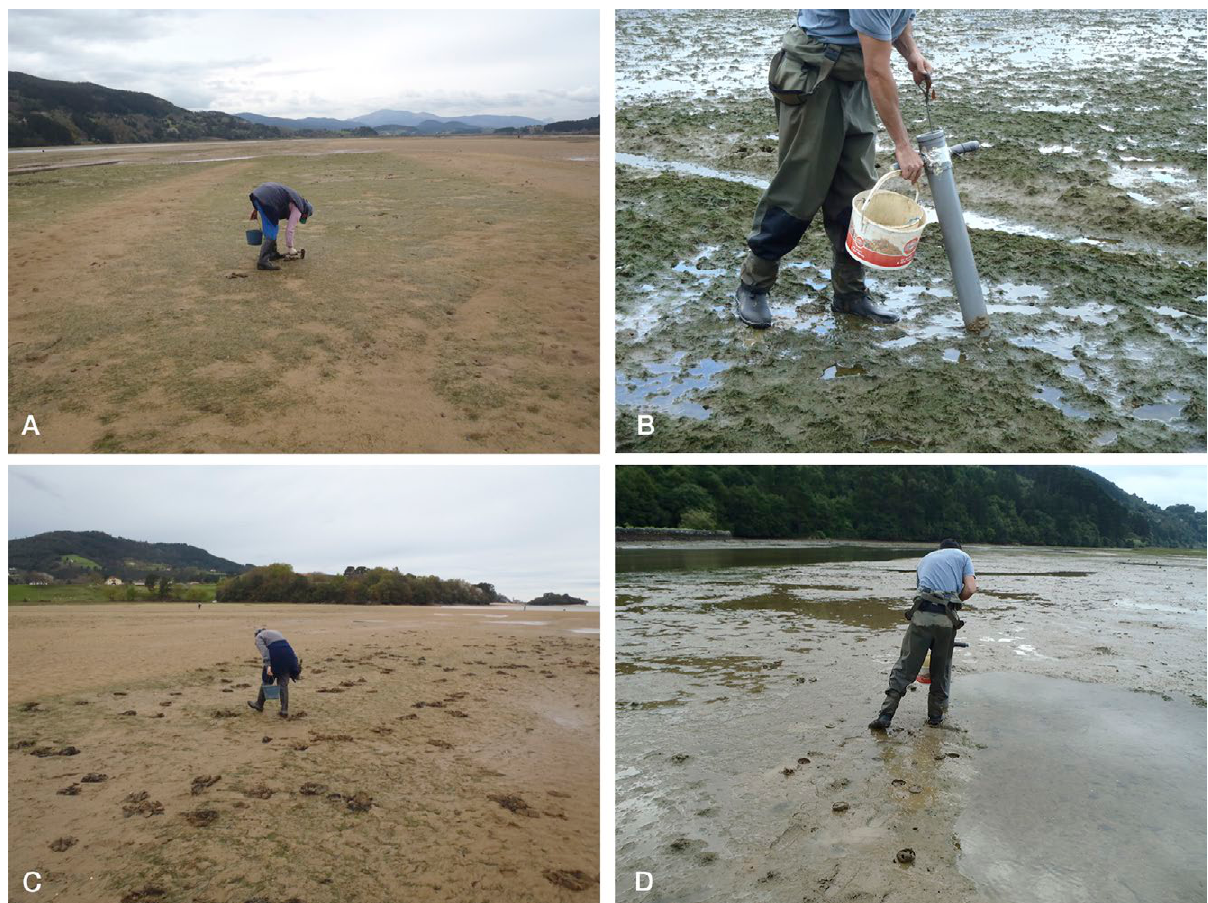
Fig. 2. – Shellfish gathering in the Oka estuary. A, bivalve harvesting; B, live bait harvesting with vacuum sucker; C and D, sediment alteration as a result of both methods of shellfish